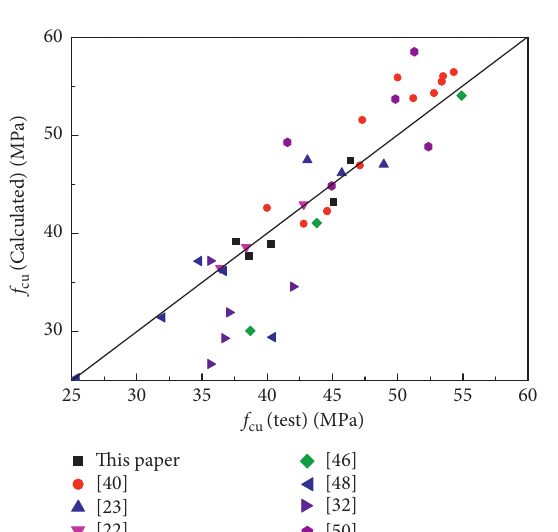
with (a) λ f and (b) v N . cu